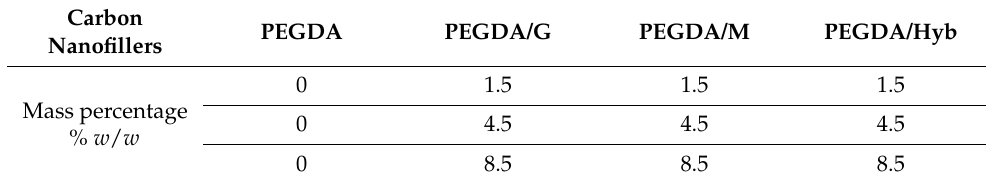
Table 1. Samples of PEGDA reinforced with carbon